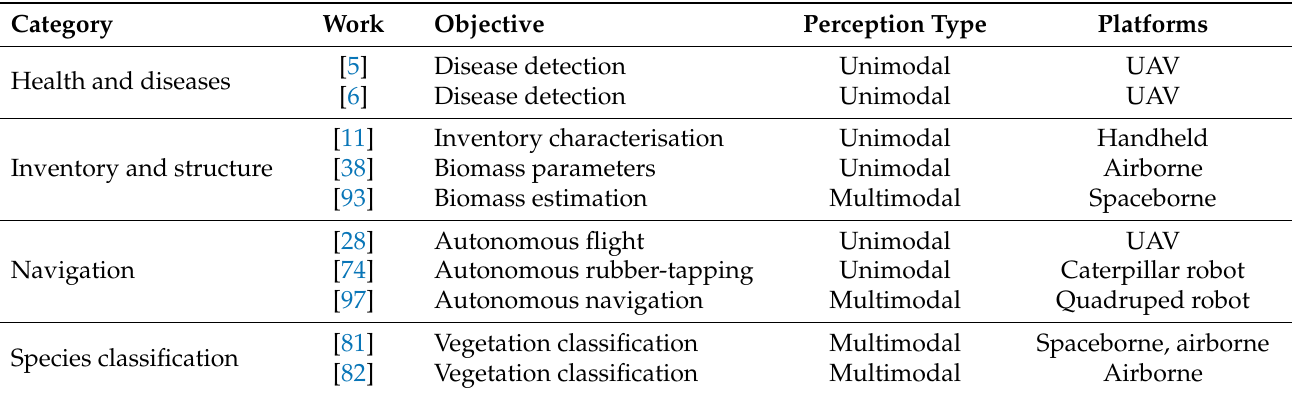
Table 3. Best works in terms of innovation in each